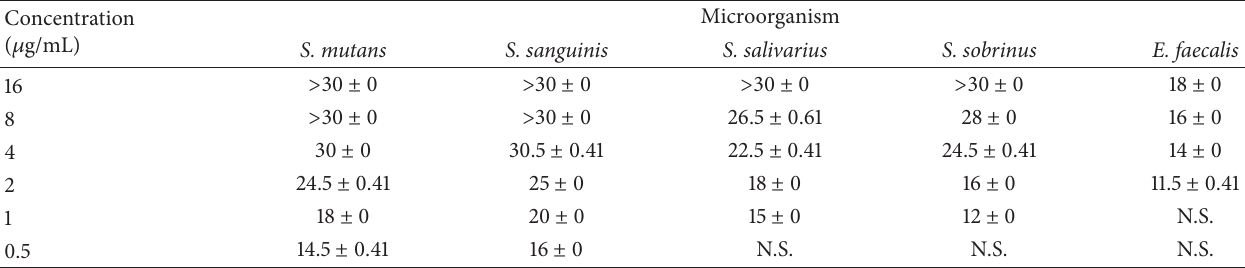
Table 5: The mean and SD of the diameter of growth inhibition zone due to the effect of ampicillin on different microorganisms. Concentration ( 𝜇